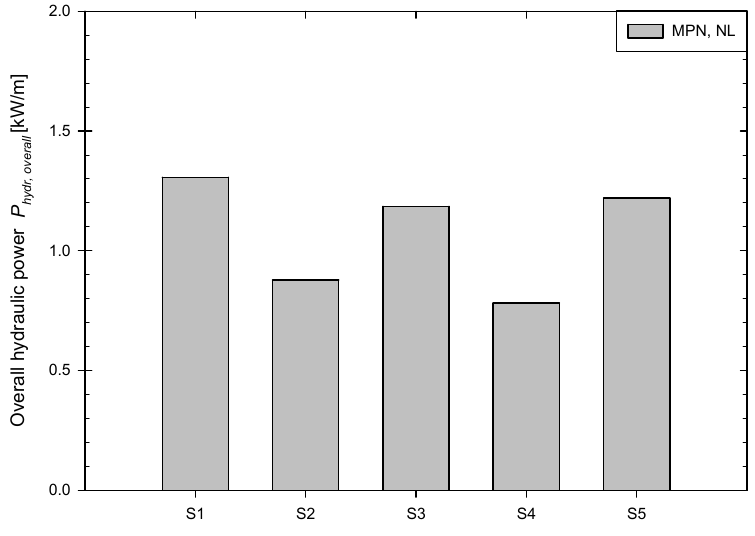
Figure B1. Comparison between effects of five scenarios on the overall hydraulic power for test site at MPN, Dutch Continental Shelf.